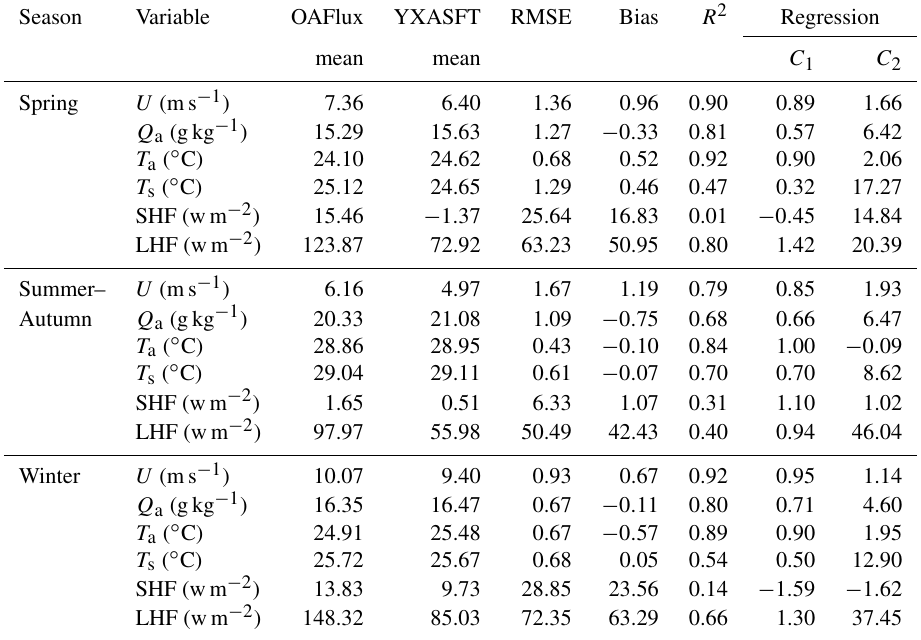
Table 3. Quantitative statistical summary based on comparisons between daily YXASFT measurements and daily OAFlux products in the spring, summer–autumn and winter